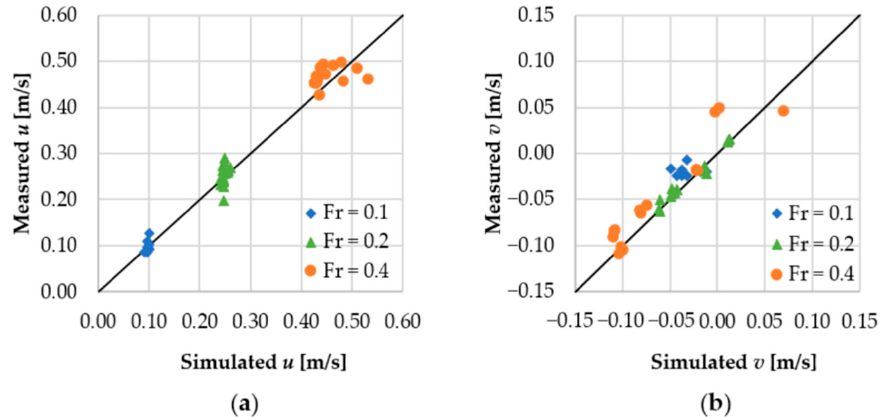
Figure 5. ( a ) Simulated and measured u velocity component and ( b ) v velocity component for the S-shaped flume, for the three tested Froude numbers.